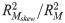
Comparing rotational structure between the representational and the dynamical models.(a) One of the two oscillatory modes (2.8 Hz) used to generate the simulated muscle activity of all conditions (2.8 Hz and 0.3 Hz). (b) Firing rate of an example neuron of the dynamical model for all 13 conditions. Each neuron is generated from a random combination of the two underlying oscillatory modes and offset for each condition. (c) Rotational dynamics in the first jPCA plane for the observed data. p-value shows results of CMPT for the representational and dynamical models evaluated by the rotational goodness-of-fit ratio (RGR: RMskew2/RM2). (d) Same as c, but for permuted data without covariance matching. (e) Same as c, but for covariance-matched data. Data is plotted for 200 ms regardless of time period used to generate statistics. Colors are based on the preparatory activity in the first jPC.